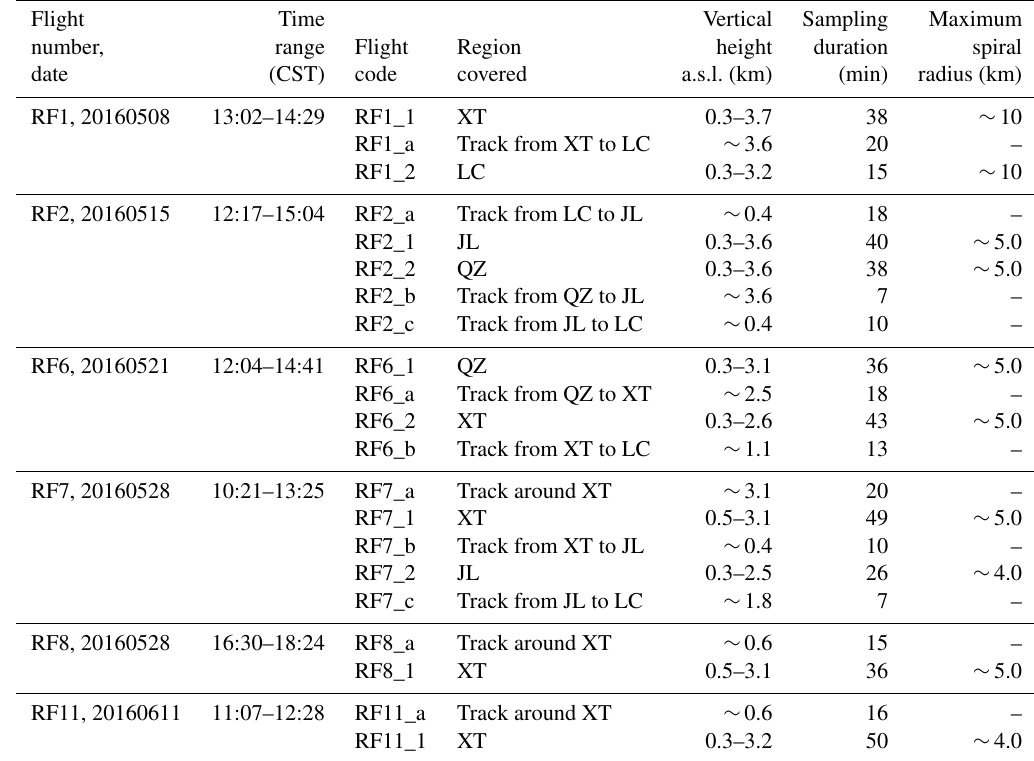
Table 1. Detailed information about the flight tracks deployed during the campaign. Flight code (third column): The number after “RF” indicates the research flight number, the number after “_” indicates the number of vertical spiral flights, and the letter after “_” indicates the number of level transects.